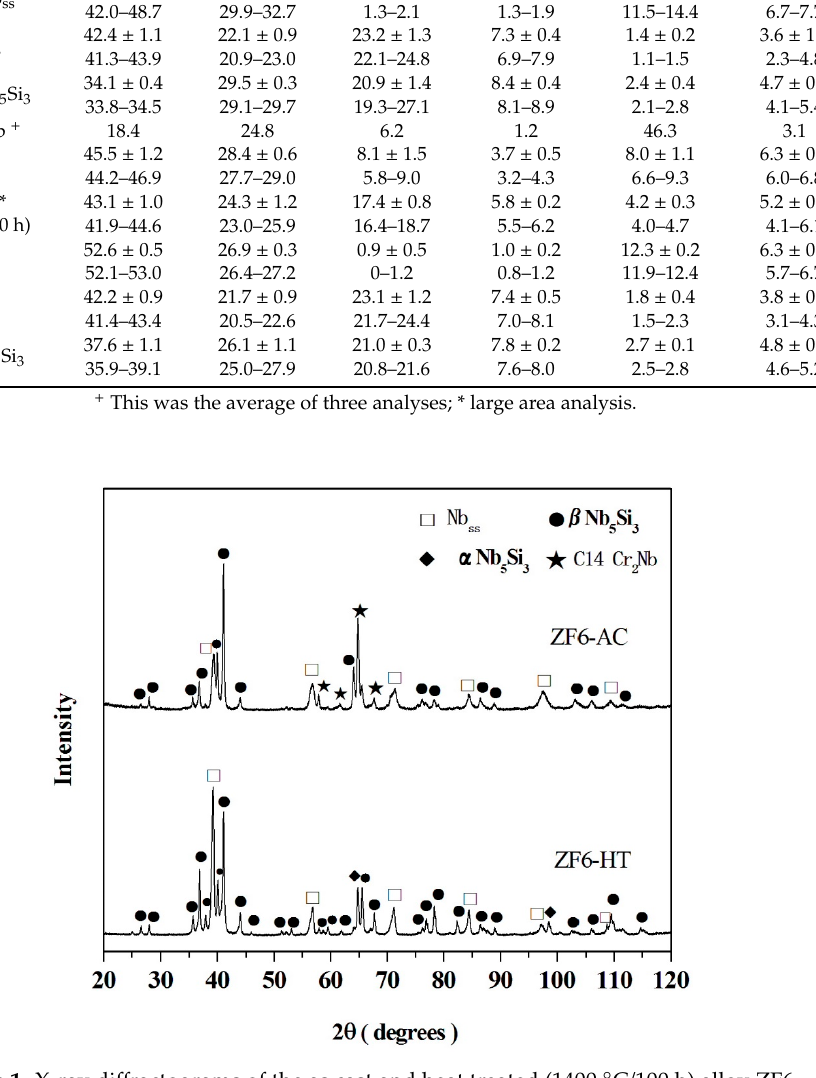
Figure 2. Typical backscatter electron images of the cross section of alloy ZF6: ( a – c ) top, bulk and bottom areas of the as cast alloy ZF6-AC; ( d ) the bulk of the heat-treated alloy ZF6-HT (1400 °C/100 h). After the heat treatment the actual composition of the heat-treated specimen (ZF6-HT) was 43.1Nb-24.3Ti-17.4Si-5.8Ge-4.2Cr-5.2Al (Table 2). The XRD data (Figure 1) would suggest that the